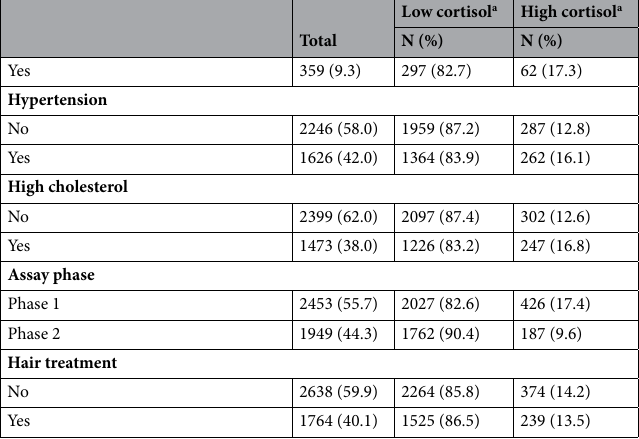
Table 1. Baseline characteristics of the sample based on the distribution of hair cortisol. a For the purpose of descriptive statistics, hair cortisol was categorised into low (< 31.1 pg/ml) and high (≥ 31.1 pg/ml) 18,19 . b Baseline covariates at wave 6 were derived from the sample used to investigate the association between hair cortisol and worsened verbal memory. c Continuous variables were expressed as mean (±